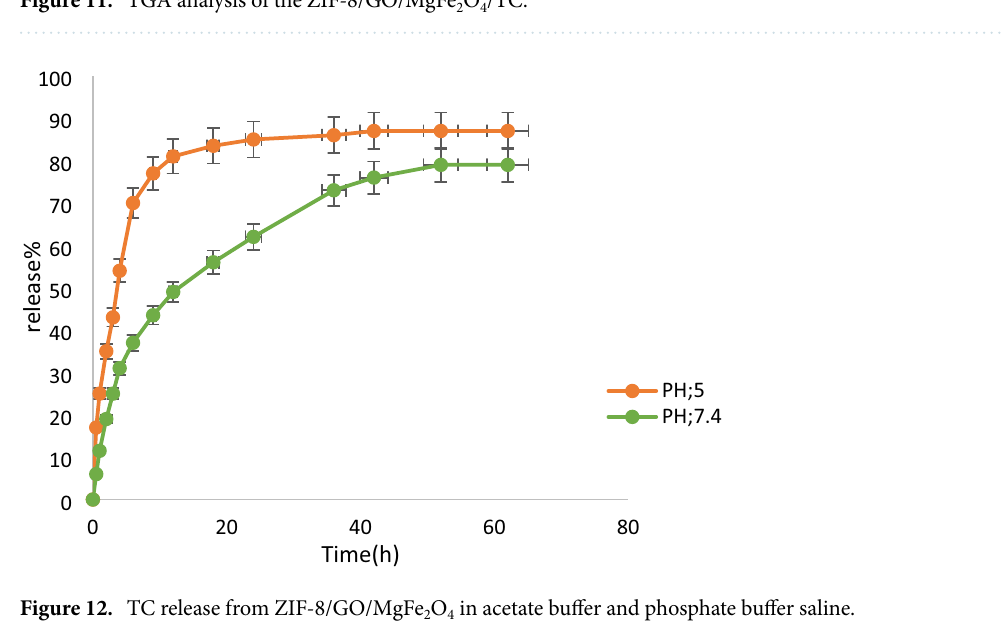
Figure 11. TGA analysis of the ZIF-8/GO/MgFe 2 O 4 /TC.